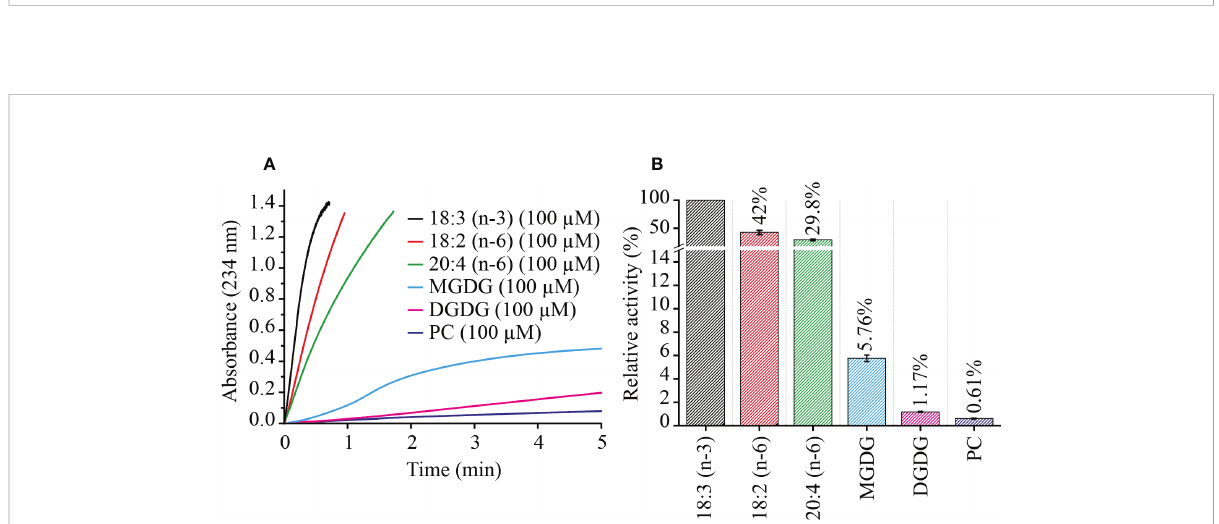
FIGURE 4 Kinetics of LiLOX with PUFAs and complex lipids extracted from L. incisa . (A) velocity of LiLOX reaction as measured spectrophotometrically at a wavelength of 234 nm. (B) Initial velocities of LiLOX with different substrates, relative to 18:3 (n-3). Error bars represent the standard deviation of three reactions from the same enzyme preparation.